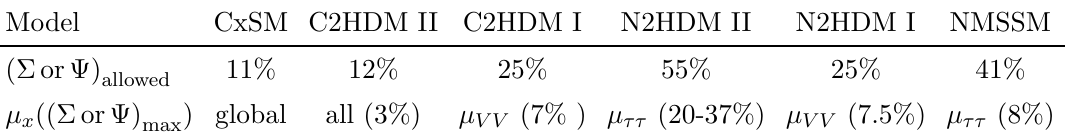
Table 4 . 2nd row: allowed singlet and pseudoscalar (for the C2HDM) admixtures; 3rd row: the most constraining (cid:22) xx together with the maximum allowed admixture after a measurement of (cid:22) xx within 5% of the SM value. The allowed CxSM admixture scales with the global signal strength. The (cid:12)rst (second) value for N2HDM II applies for medium (small) tan (cid:12)